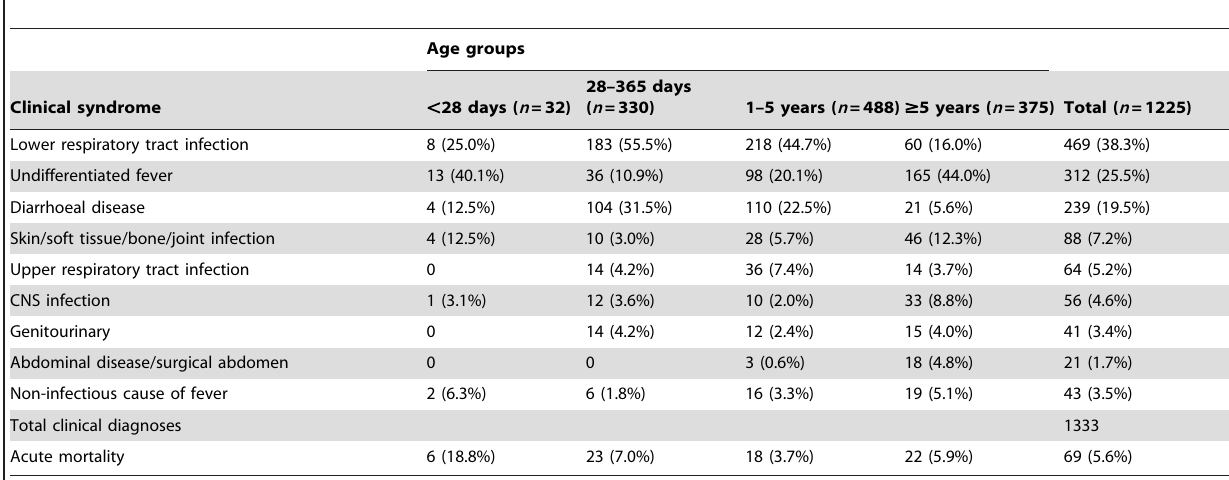
Table 2. The presenting clinical syndromes diagnosed for 1225 episodes of febrile illness over the one-year study period.